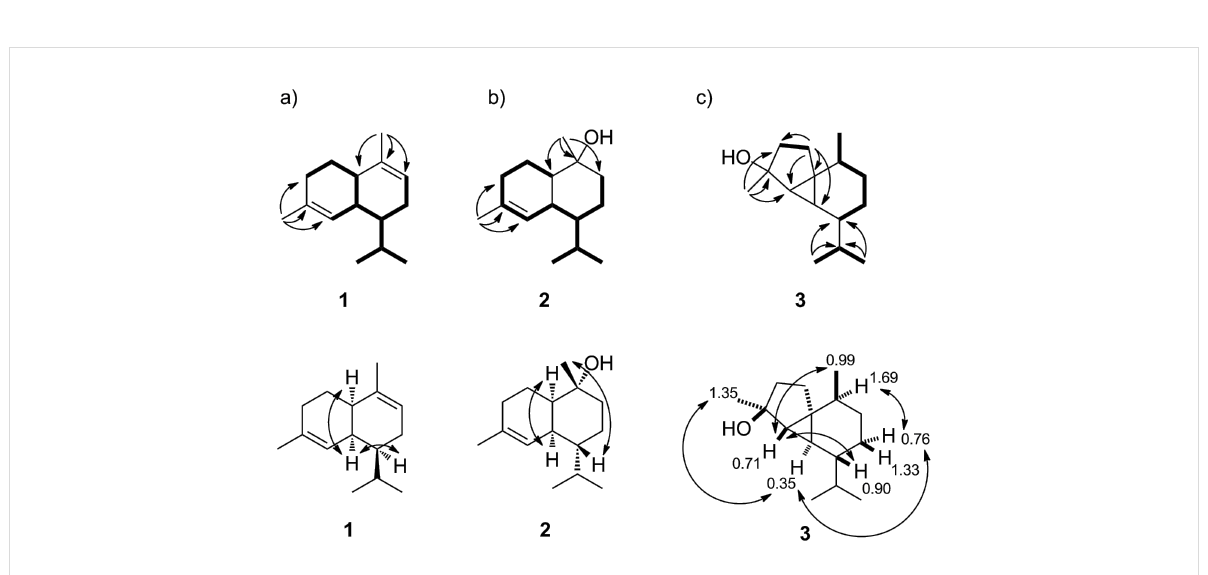
Figure 2: Contiguous spin systems observed by 1 H, 1 H-COSY (bold), key HMBC and NOE correlations for a) α -amorphene ( 1 ), b) T-muurolol ( 2 ), and c) 4- epi -cubebol ( 3 ). 1 H NMR shifts are given in ppm.